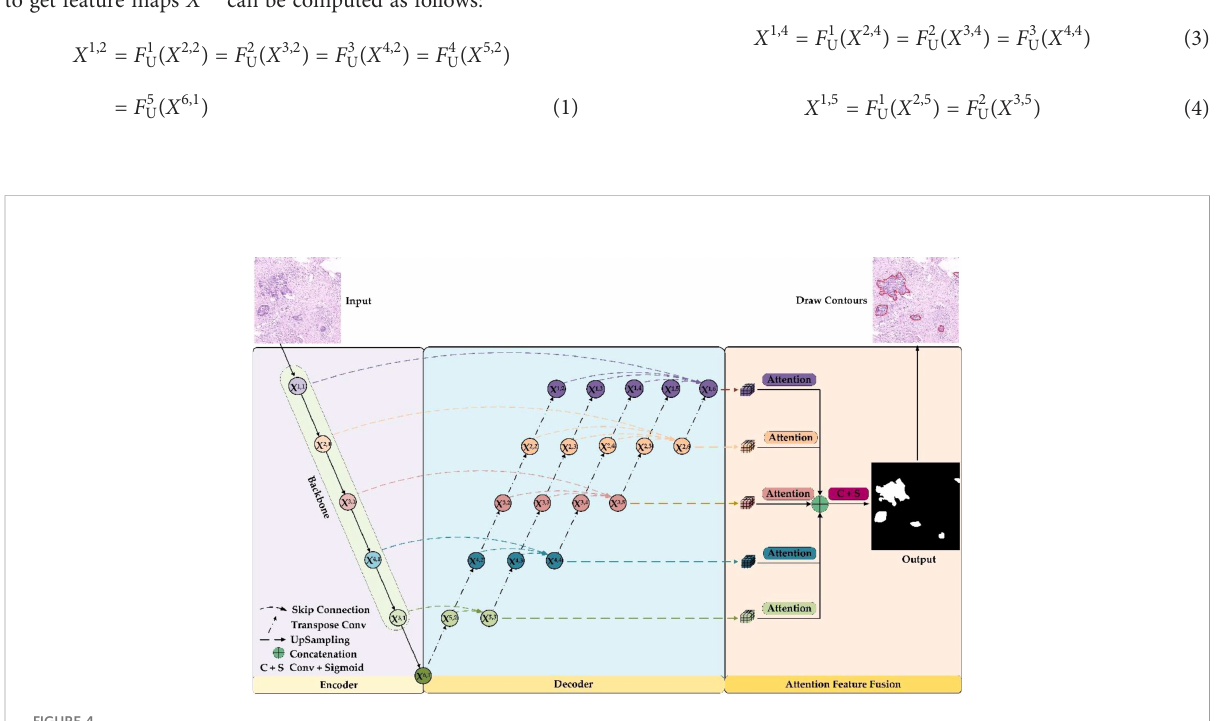
FIGURE 4 The overall framework of the